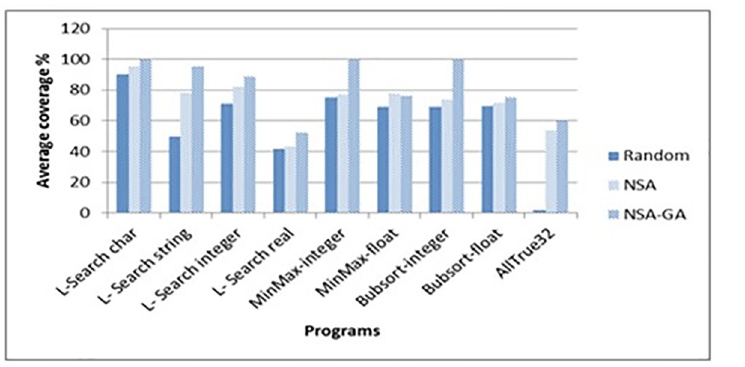
Fig 14. Average coverage of all loops programs with different data